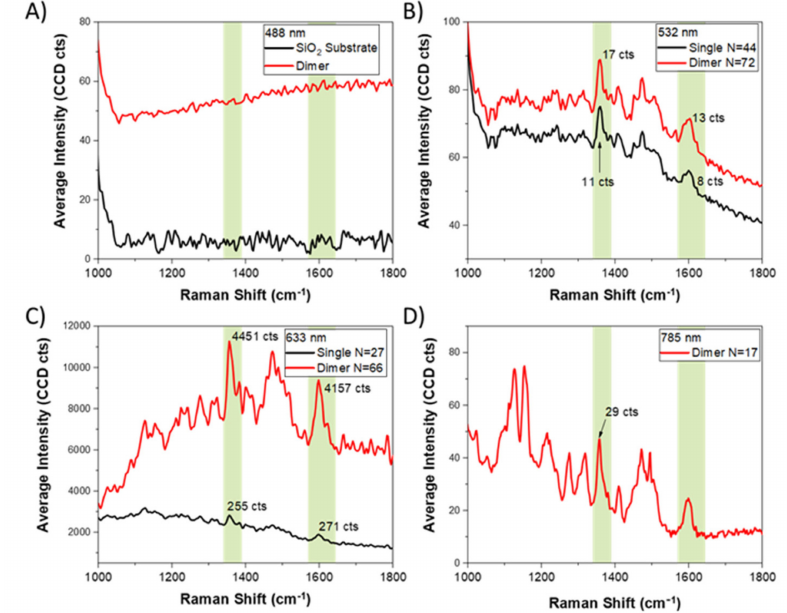
Figure 4. Averaged SERS spectra of self-assembled dimers or single nanoparticles composed of 60 nm AuNPs modified with Cy5, collected from the correlated data. In the insets, the number of spectra that were used to obtain the average data is given. The exciting wavelengths used were ( A ) 488 nm, ( B ) 532 nm, ( C ) 633 nm and ( D ) 785 nm. In all Raman experiments, the laser power was kept at 300 µ W and the integration time was 2